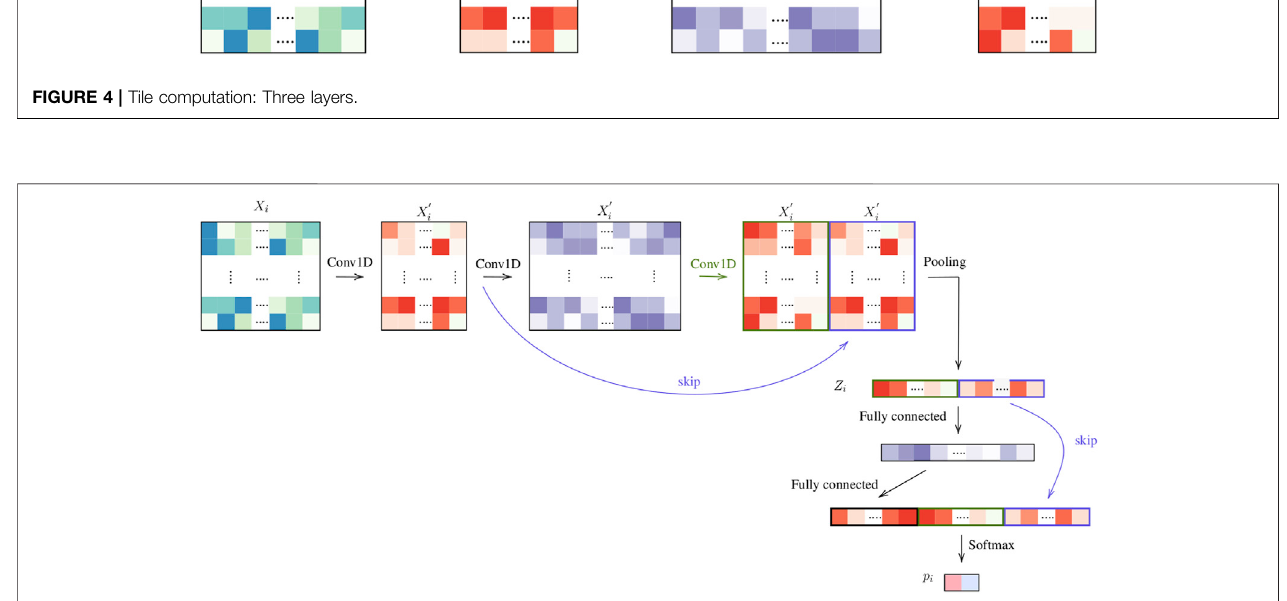
FIGURE 5 | ThreeTwoSkip.